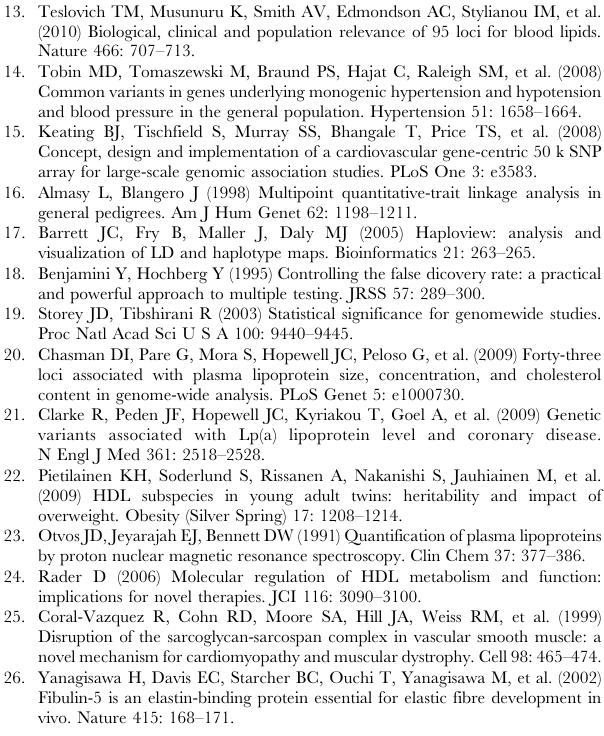
Table S2 Lead SNPs for 10 genes with the strongest association results for mean HDL particle size. Results are from GEE regression analyses adjusted for age, age 2 and gender. The right part of the table shows association results of the SNPs with the other two measured traits’ mean HDL cholesterol and HDL particle number. Chr.: chromosome; MAF: minor allele frequen- cy; beta: beta coefficient per minor allele copy; SE: standard error. A negative beta coefficient indicates a lower value for the trait for